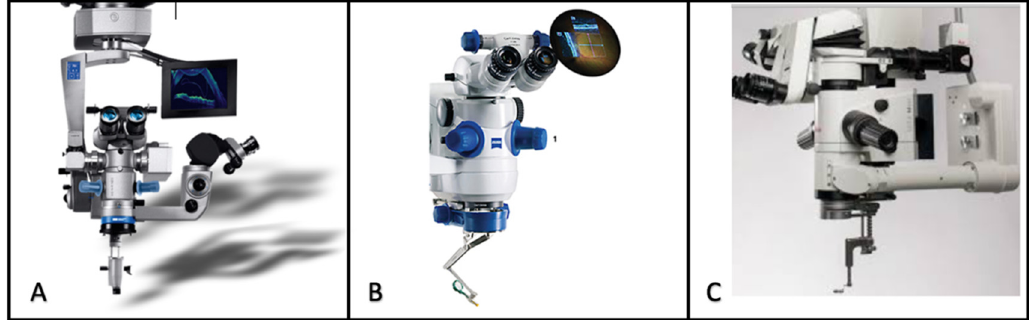
Figure 1. Commercial MI-OCT systems. ( A ) Haag—Streit Surgical iOCT system, ( B ) Zeiss RESCAN 700 system, and ( C ) Leica EnFocus system.